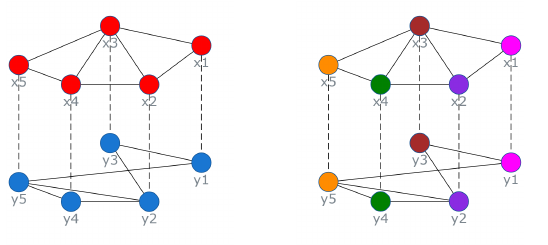
Figure 4. The topological diagram of the two − layer coupled network for ALS ( left ) and RLS ( right ).